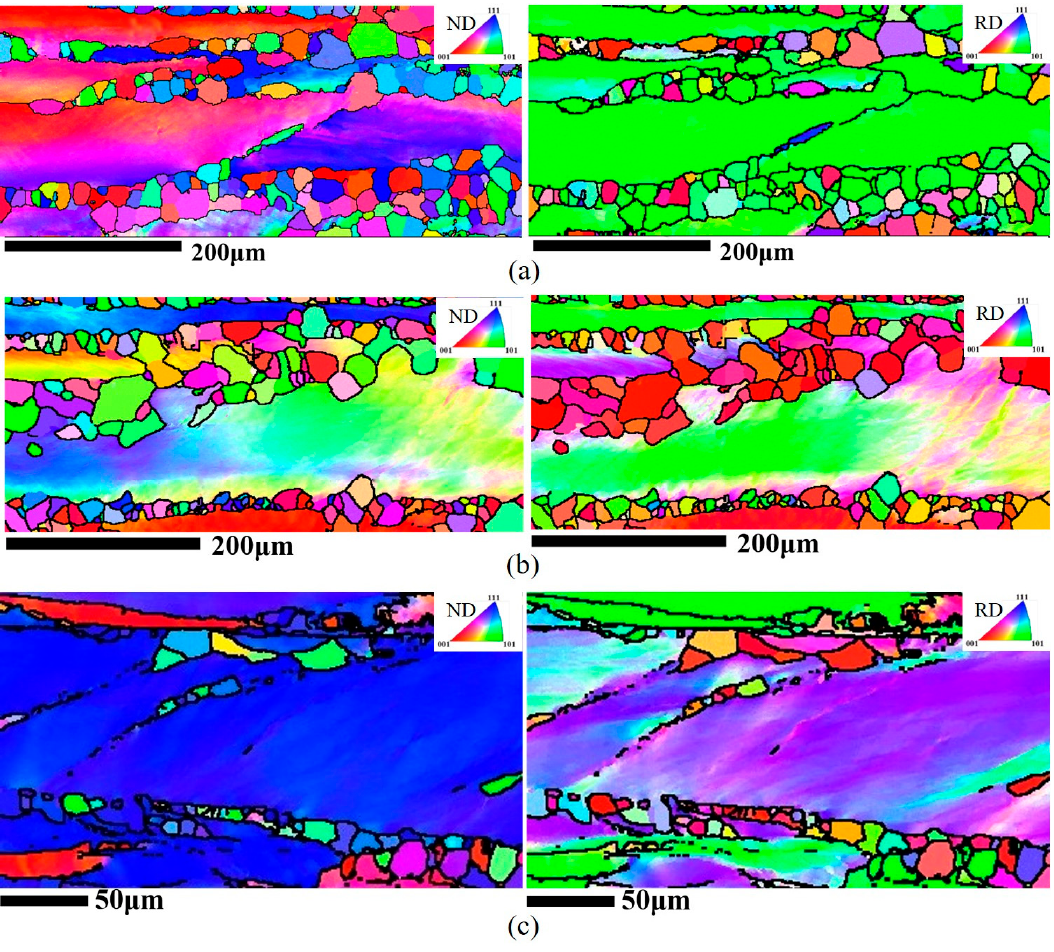
Figure 5. Orientation image map of partially recrystallized samples: ( a ) 0Cu, 900 °C × 30 s; ( b ) 0.5Cu, 900 °C × 30 s; and ( c ) 0.5Cu, 900 °C × 15 s. The left images are of the normal direction (ND), while the right images are of the rolling direction (RD).